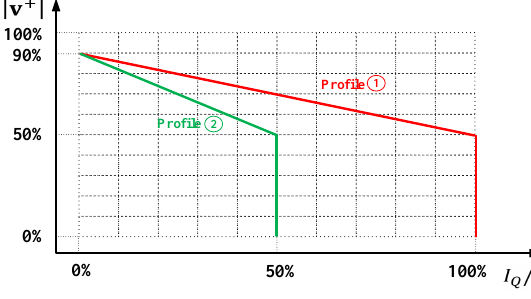
Figure 9. Reactive current profiles used to generate reactive power